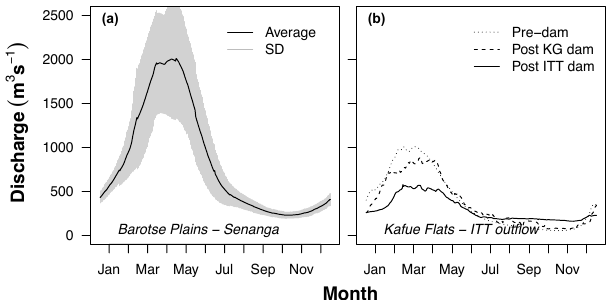
Figure 2. River discharge (a) at Senanga, the downstream bound- ary of the Barotse Plains (1988–2006 average and standard devi- ation), and (b) at the outflow of Itezhi-Tezhi (ITT) dam, the up- stream boundary of the Kafue Flats. Discharge for the Kafue Flats are means of pre-dam (1960–1971) and post-dam construction (Ka- fue Gorge dam: 1972–1977; ITT dam: 1978–2010) periods. Data from the Department of Water Affairs and Zambezi River Author- ity; permission for reprint first granted to Blaser (2013).